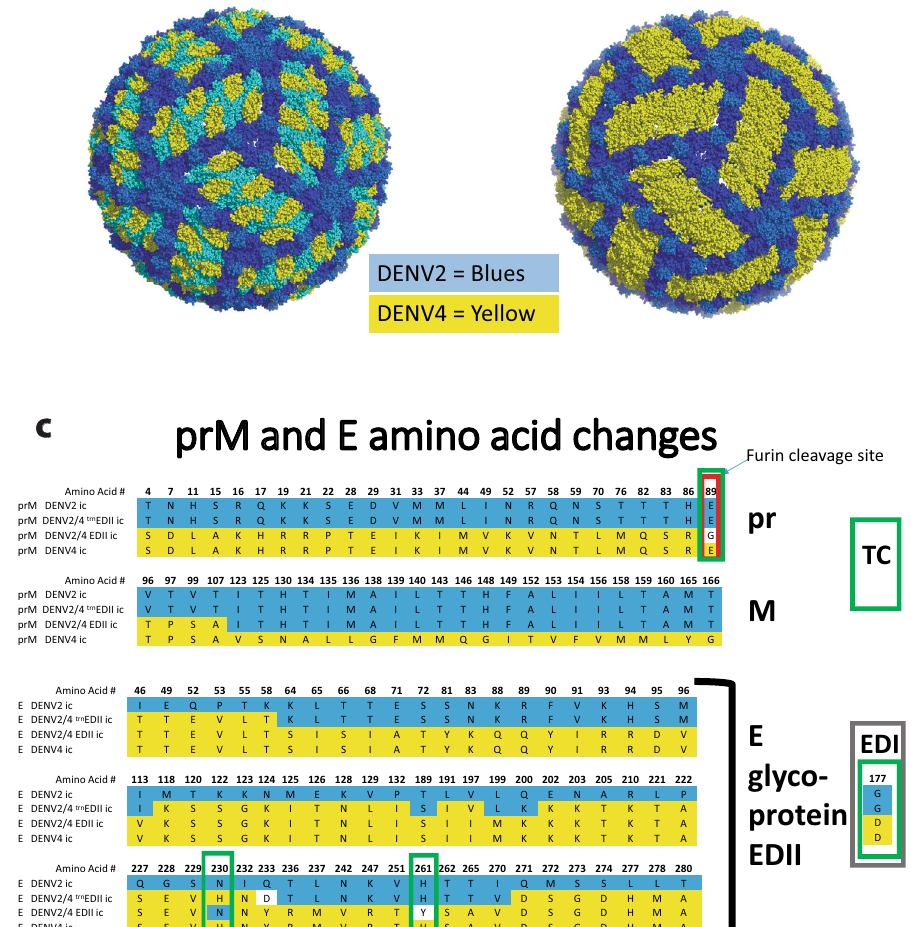
Fig.1|MolecularmodelsofVirions.a PyMOLsoftware-generatedrepresentations of changed residues. DENV2/4 trn EDII virion with a truncated EDII transplanted DENV4 region in yellow. DENV2 backbone in shades of blue, EDI - dark blue, EDII – light blue, EDIII – medium blue. b DENV2/EDII virion with transplantedDENV4EDII in yellow. DENV2backbone in shadesofblue, EDI - darkblue, EDIII – medium blue. c Amino acid changes to prM and E glycoproteins. Chimeric prM is shown in comparison with parental DENV2 and DENV4 prMs. In the chimeric DENV2/4 prM, amino acids 1-107 are from DENV4 and amino acids 108-166 are from DENV2 with